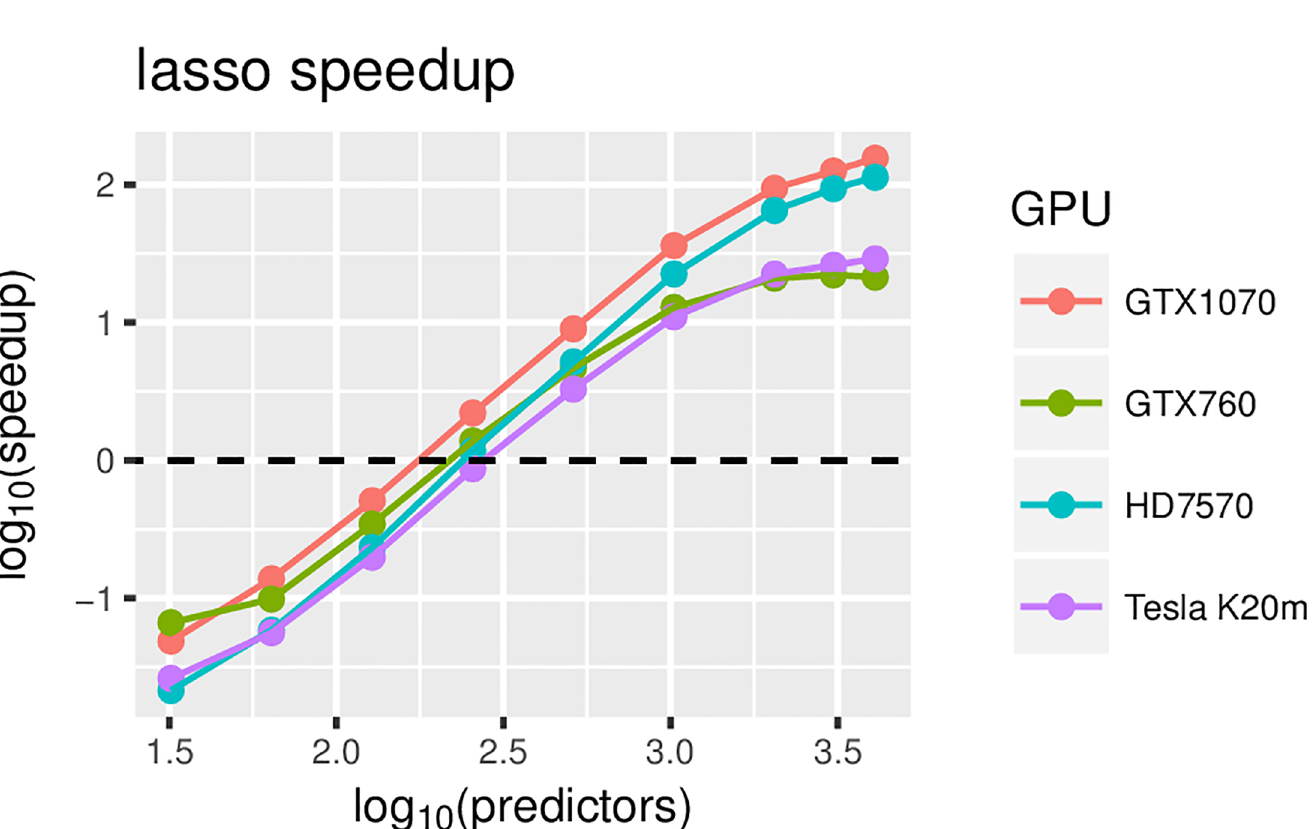
PLOS ONE | https://doi.org/10.1371/journal.pone.0180343 June 28,